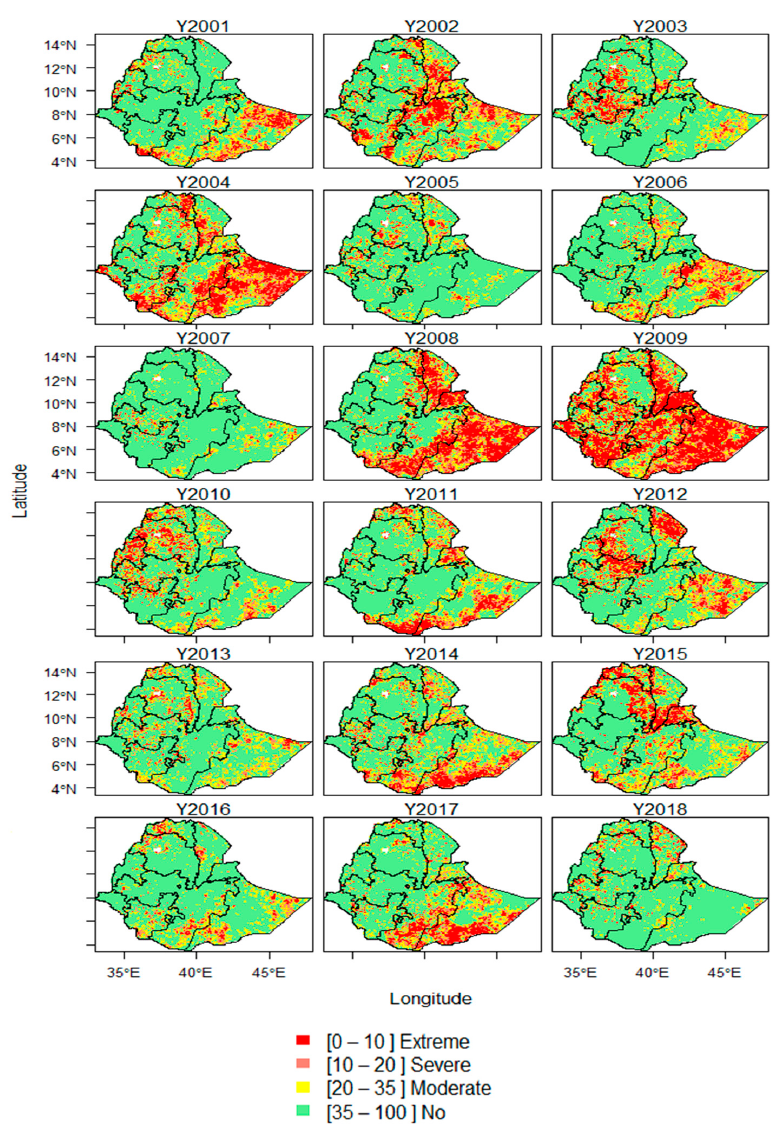
Figure 5. The spatio–temporal variability droughts detected by the NDVI-based vegetation condition. index for the growing season in Ethiopia for the period 2001 to 2018.